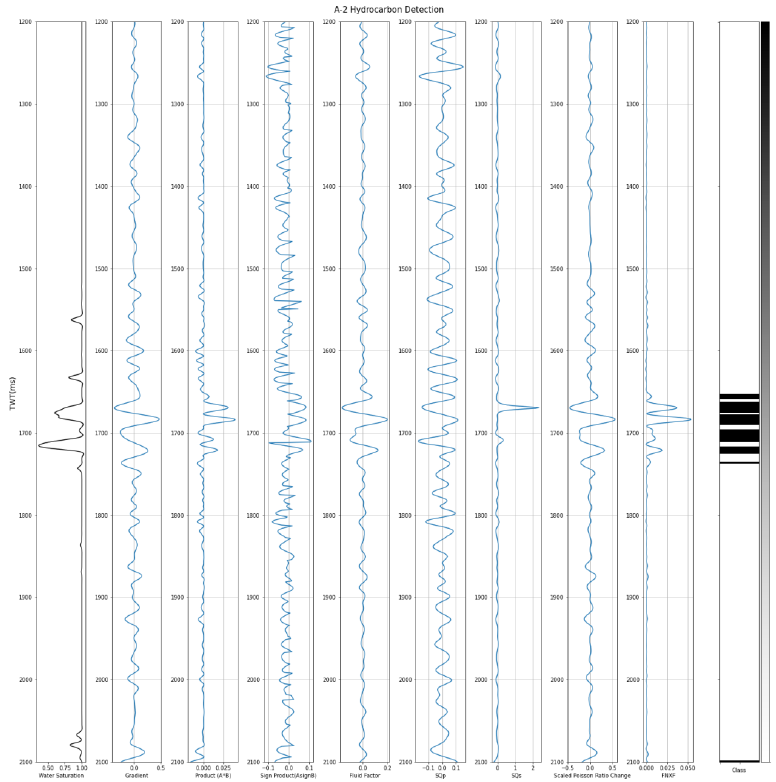
Figure 12. Hydrocarbon delineation on A −